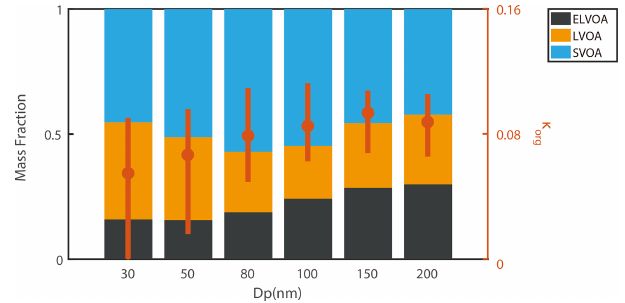
Figure 3. The average mass fraction distribution of SVOA, LVOA, and ELVOA at the measured diameters (30, 50, 80, 100, 150, and 200nm) and average size-resolved hygroscopicity of organic aerosol ( κ OA ) with the upper and lower error bars (in